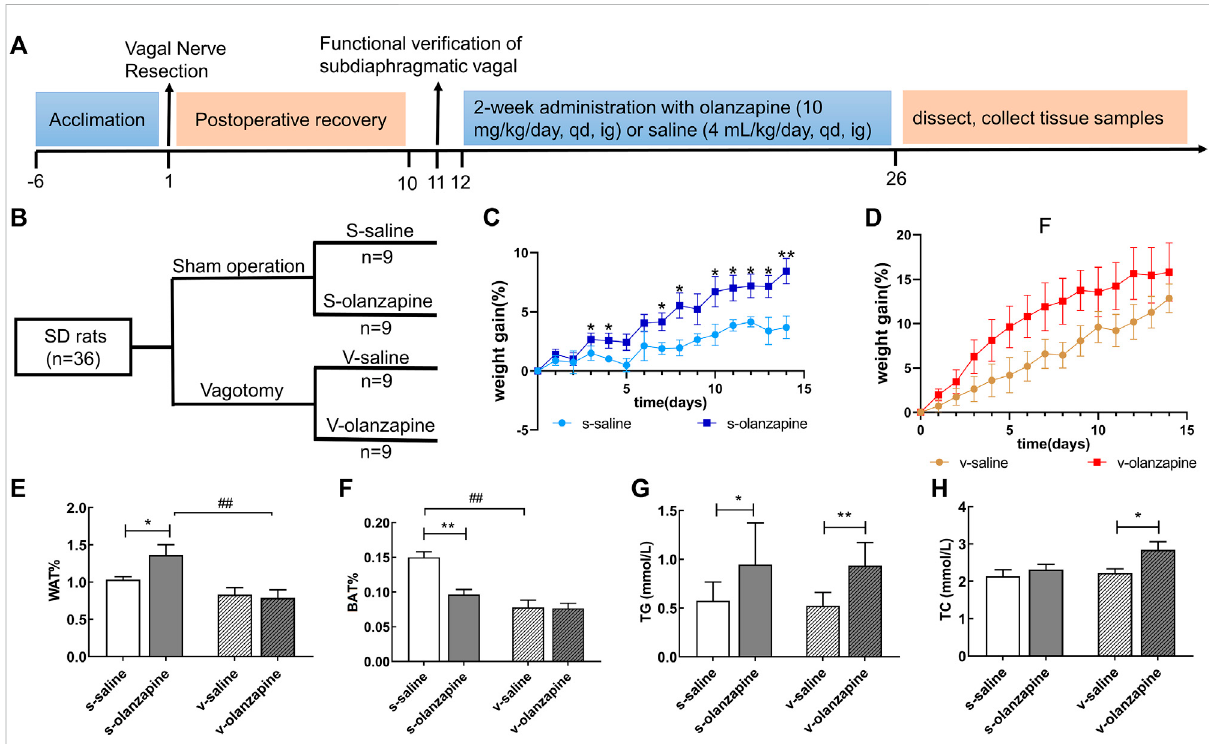
FIGURE 1 The experiment was designed following the timeline (A) and grouping (B) . The results of lipid parameters are indicated as: weight gain (%) changes over time in the sham groups (C) and in the vagotomy groups (D) ; the weight percentage of the white adipose tissue in the groin (E) and of thebrownadiposetissue between thescapula (F) ;and theserum levels of (G) triglyceride(TG)and (H) totalcholesterol(TC)in differentgroups.Data are represented as the mean ± SD, * p < 0.05, ** p < 0.01 and ## p <